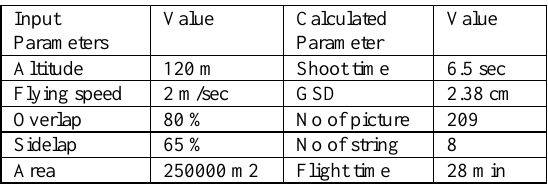
Table 1. Flight parameter in Mission Planner